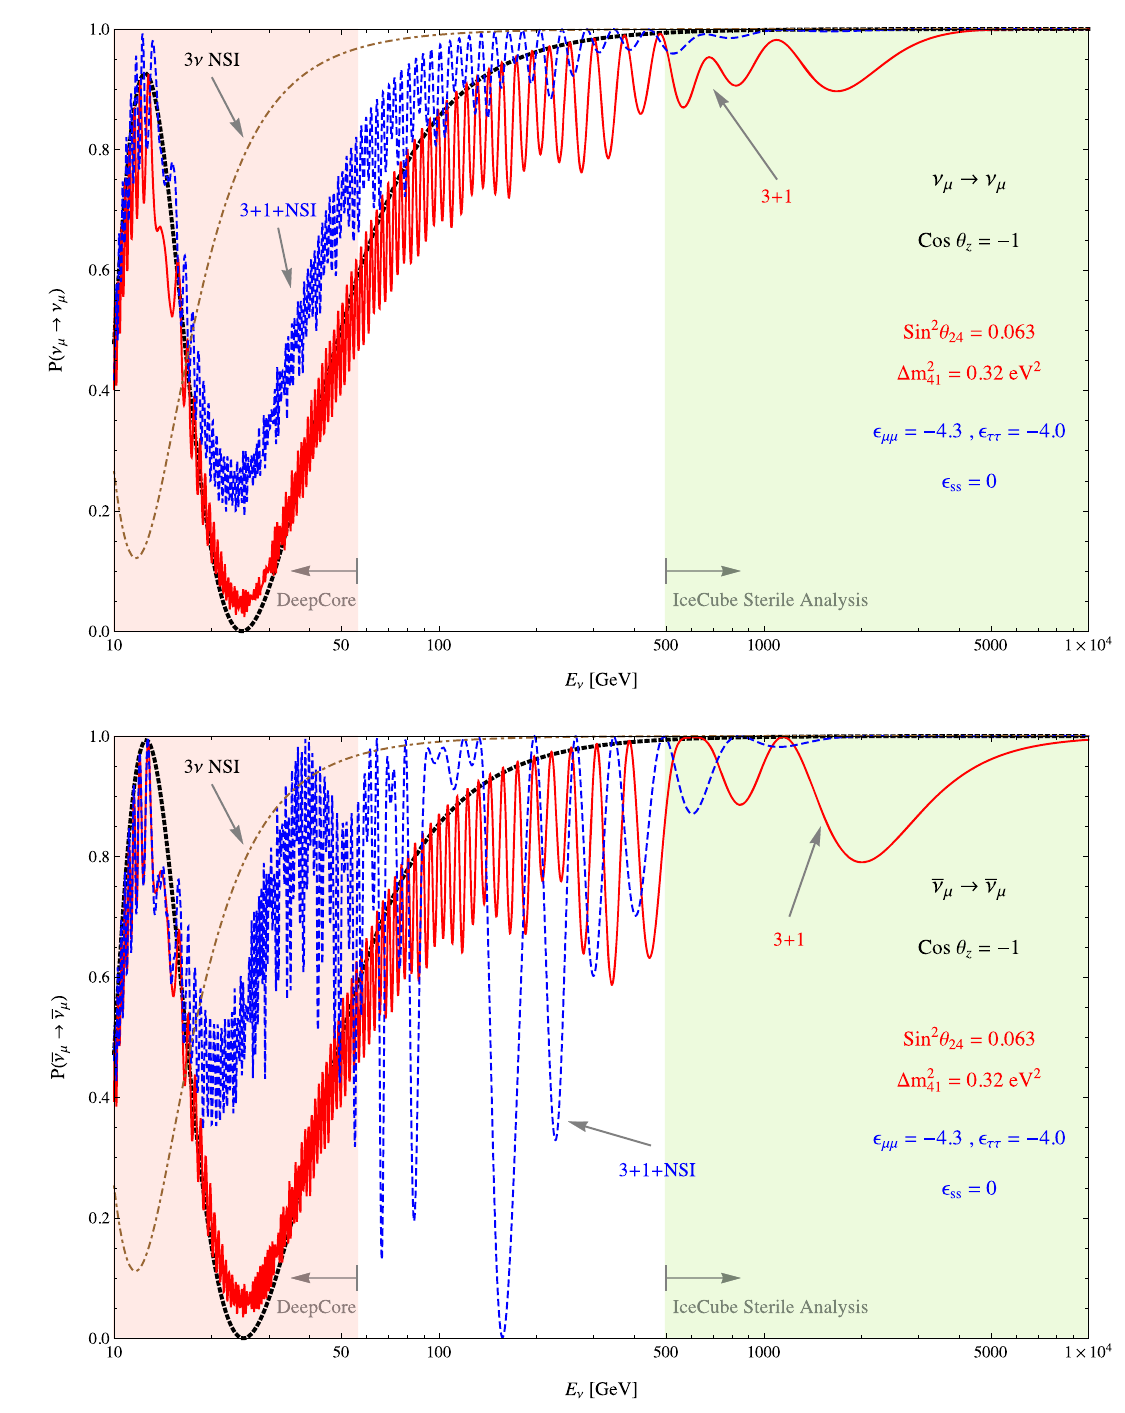
Fig. 2 The same as Fig. 1 but for cos θ z = − 1